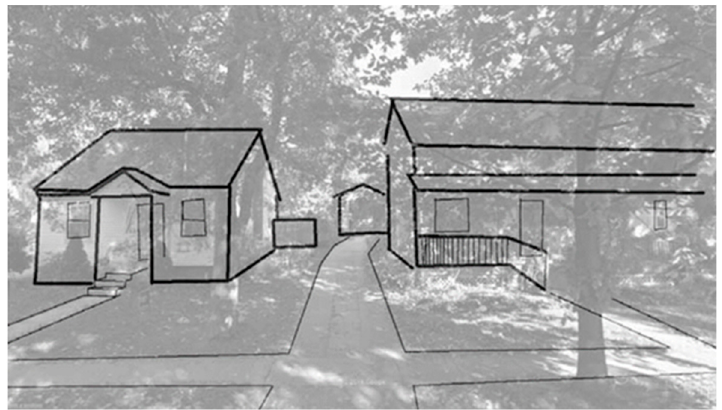
Figure 6. The overall sketch illustrates how the fence at the back of the house creates an opportunity for reduced informal guardianship. This is a good example of having increased values in